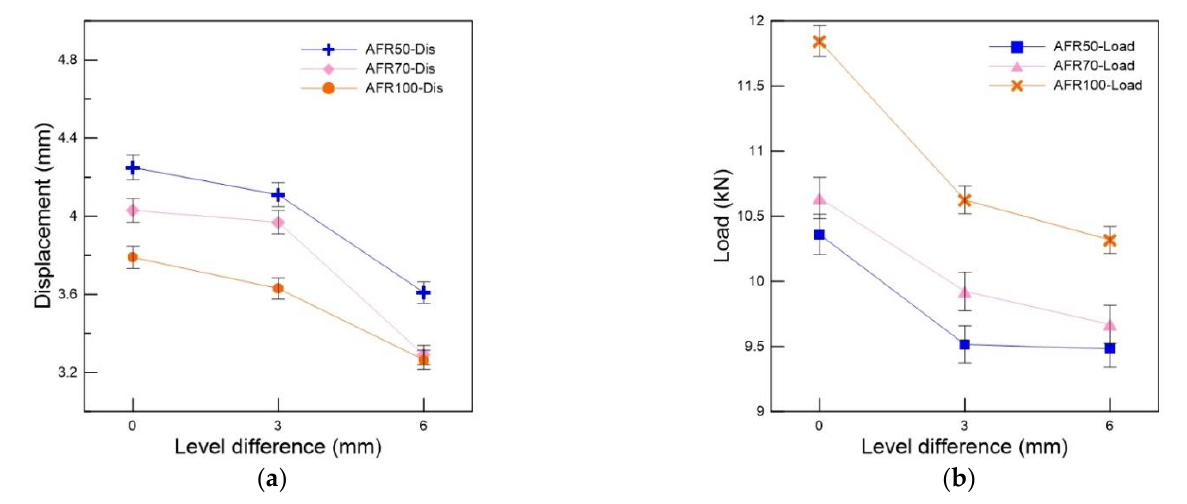
Figure 9. Tensile load and displacement curves of specimens with various level differences : ( a ) 0 mm, ( b ) 3 mm, and ( c ) 6 mm.